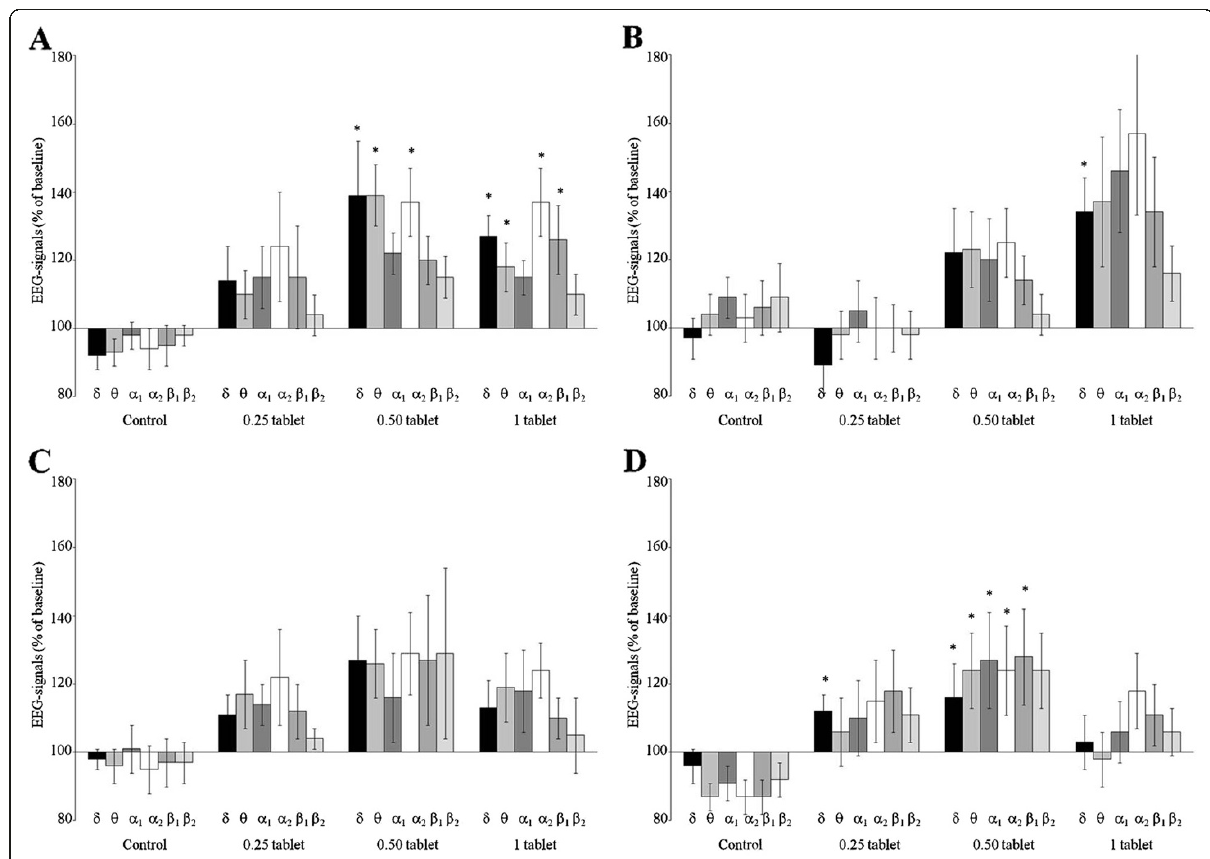
Figure 1 Effects of control and 0.25, 0.50, and 1 tablet of Neurexan on the spectral frequencies in four rat brain areas (frontal cortex [A], hippocampus [B], striatum [C], and reticular formation [D]). The encephalographic (EEG) signatures were obtained between 185 and 245 minutes after oral administration of a single dose of Neurexan. Changes of δ -, θ -, α 1-, α 2-, β 1-, and β 2-waves are presented as percentage of predrug baseline. The data of eight rats are summarized as mean±SEM. Significant differences to vehicle controls (0.9% NaCl) are indicated by asterisks ( P